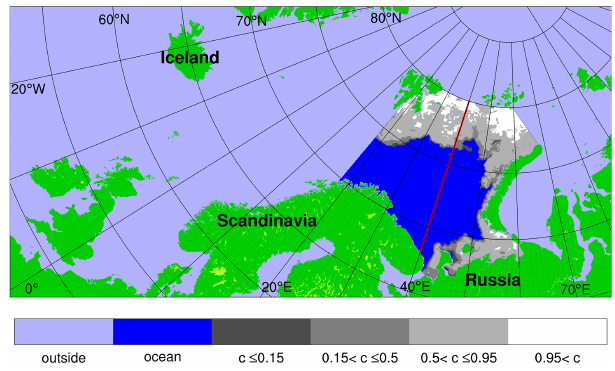
Figure 4. Map of the full SVIM simulation domain. The Barents Sea analysis region in the present study is shown as a highlighted region where a sample sea ice concentration distribution is depicted. The 40 ◦ E meridian which will subsequently be used for dividing the domain into two parts is displayed by the red curve. The shading of ice concentration values is given in the label bar, where c is the sea ice concentration fraction. This sample shows the model results for 15 April 2000 with the horizontal resolution from the SVIM experiment. See the text for details about the SVIM archive.